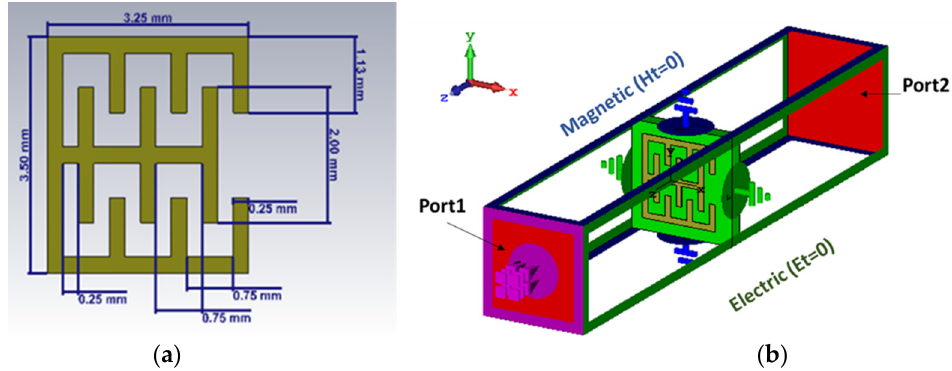
Figure 5. Metamaterial unit cell: ( a ) schematic of the proposed cell model unit; ( b ) 3D view of the simulation setup of the unit cell.